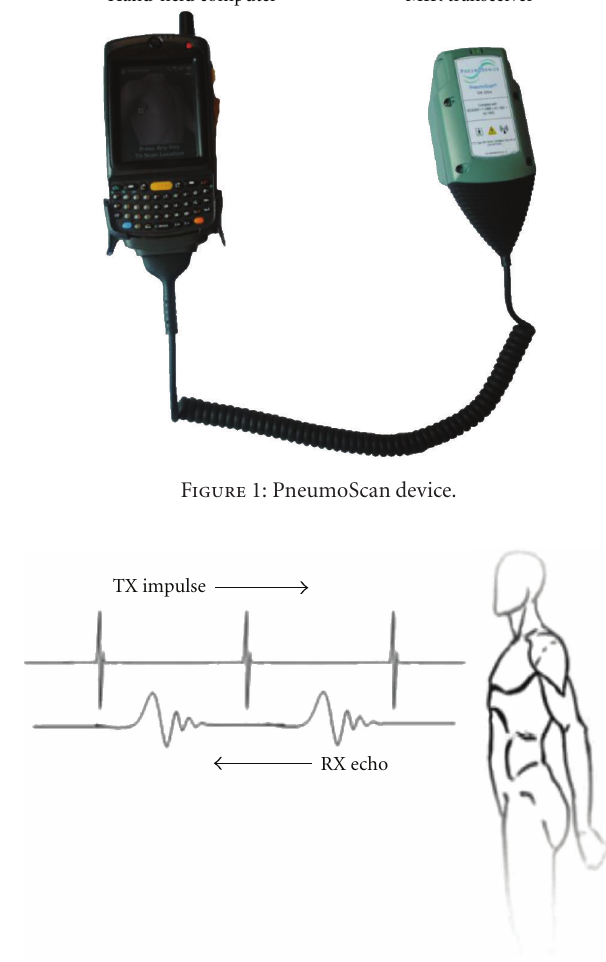
Figure 2: Micropower impulse radar